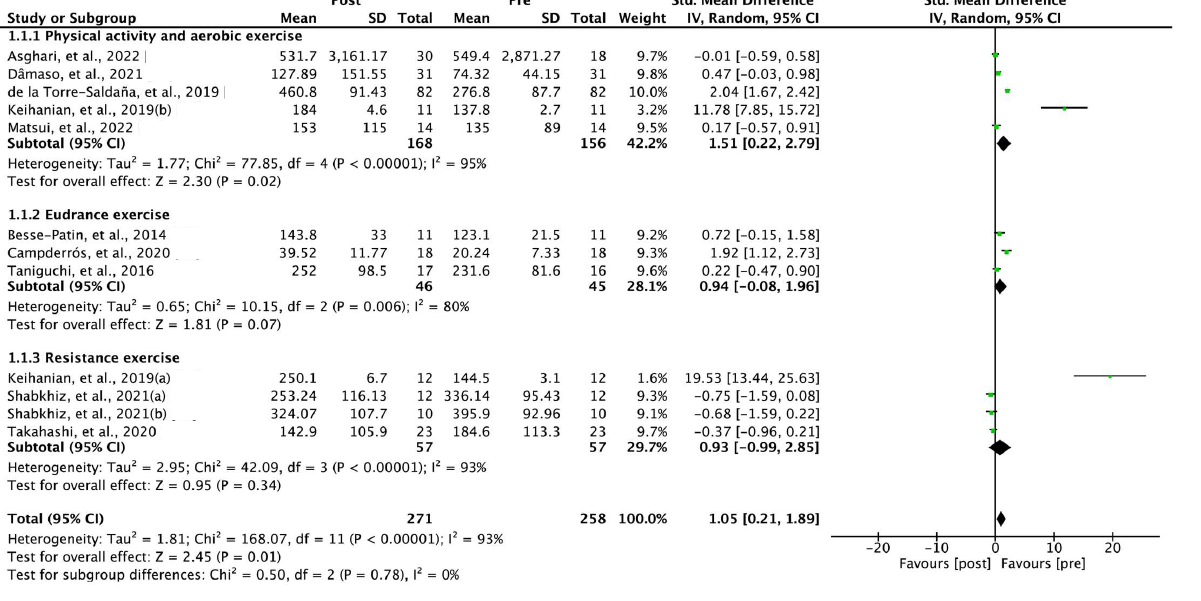
Figure 3. Forest plot of within-group comparisons of exercise-induced changes in fibroblast growth factor-21 levels [26–35]. Keihanian et al., 2019(a) [29]—resistance exercise; Keihanian et al., 2019(b) [29]—aerobic exercise; Shabkhiz et al., 2021(a) [30]—participants without type 2 diabetes; Shabkhiz et al., 2021(b) [30]—participants with type 2 diabetes.